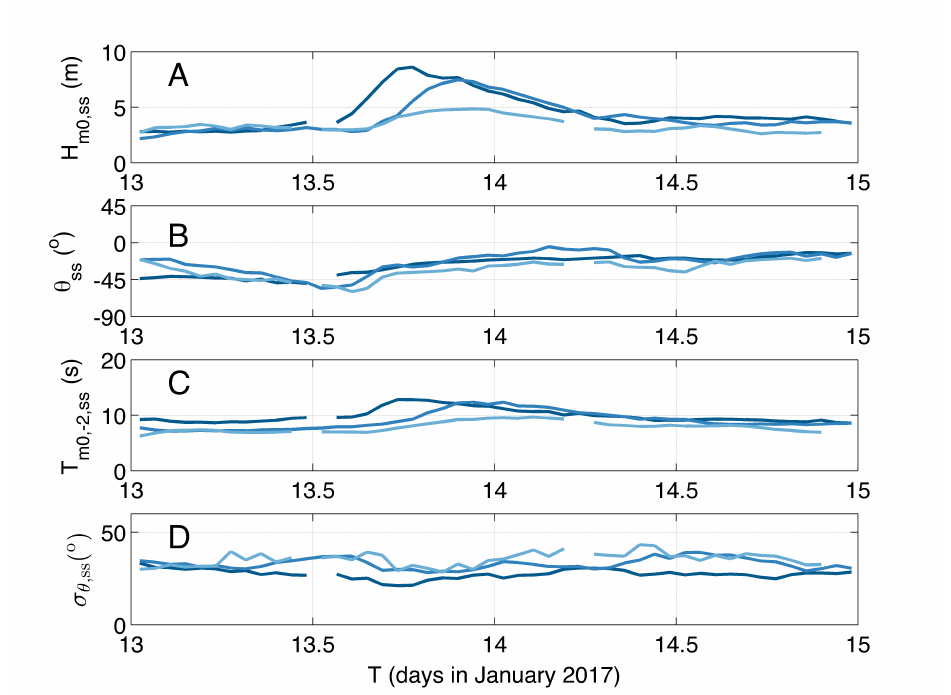
Figure 5. Sea-swell conditions during storm Egon at locations A12 (dark blue), Q1 (blue) and EUR (light blue). ( A ) Significant Wave height. ( B ) Mean wave direction (Nautical convention). ( C ) Wave period T m 0, − 2 . ( D ) Mean directional